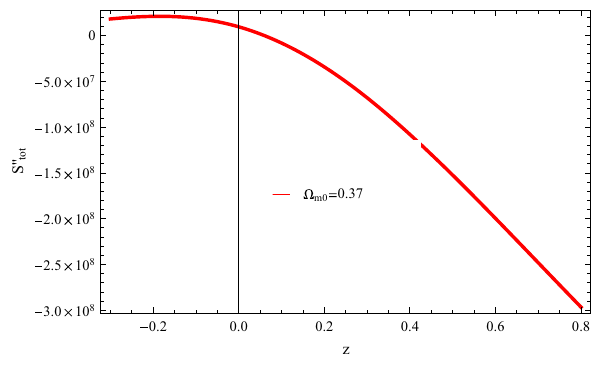
Fig. 13 Plot of w ef f versus z at Hubble horizon with Bekenstein entropy